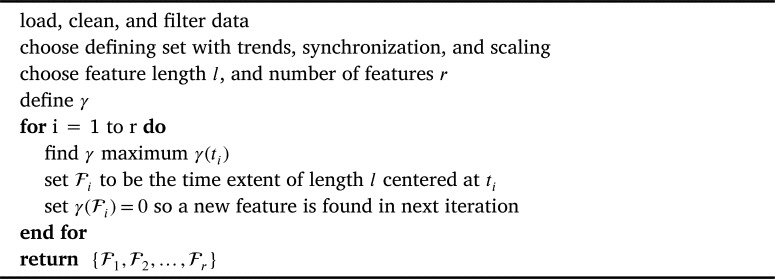
Identify Features